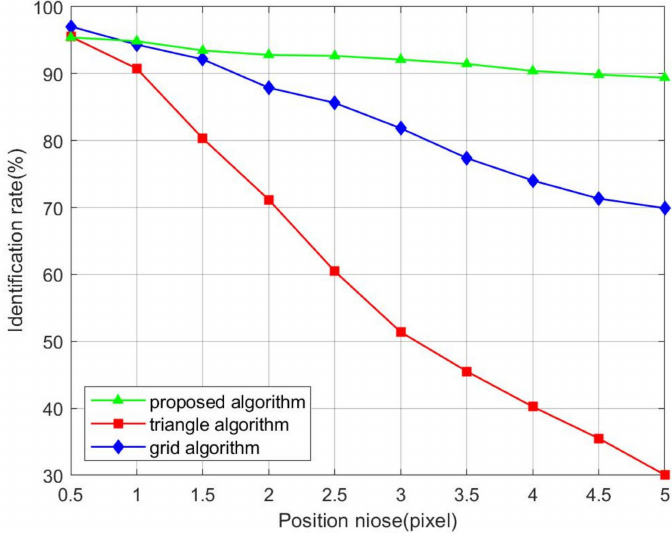
Figure 9. Effects of position noise on the identification rate at an angular velocity of 0 ◦